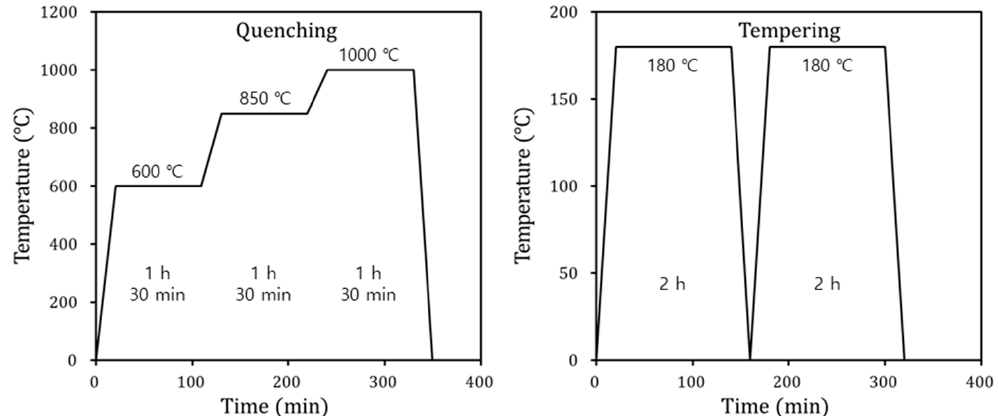
Figure 4. Heat treatment conditions of the pin, consisting of quenching ( left ) and temperature ( right ). Table 2. Chemical composition of the DP980 and STD11 steel (wt%).